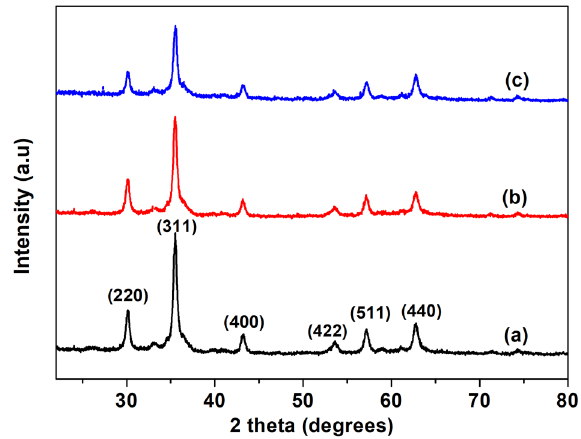
Fig. 1 XRD pattern of a Fe 3 O 4 , b PANI-coated Fe 3 O 4 , and c polypyrrole-coated Fe 3 O 4